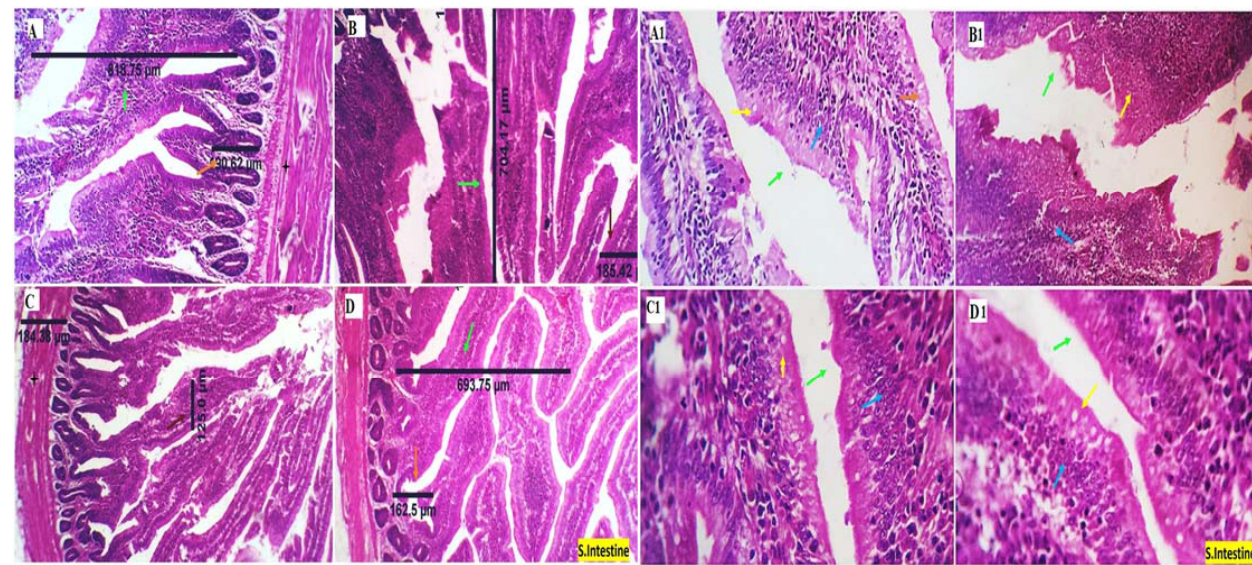
Figure 2. Photomicrograph of the small intestine showing the effect of dietary FO supplementation on different intestinal morphometric measures. VH (green arrows); VW (brown arrows); CD (orange arrows); MCT (black stars). Routine H&E showed a moderate number of goblet cells in FO400 and FO600 groups (16, 17 cells/HPF, respectively) but high numbers in FO0 and FO200 groups (25, 38 cells/HPF, respectively). The FO200 group shows mild villous epithelial stratification with multilayered and proliferated cells having central rounded nuclei and abundant eosinophilic cytoplasm. The normal arrangement of villous cells is seen in other groups. ( A , A1 ), FO0; ( B , B1 ), FO200; ( C , C1 ), FO400; ( D , D1 ), FO600, H&E × 100, 200, respectively.